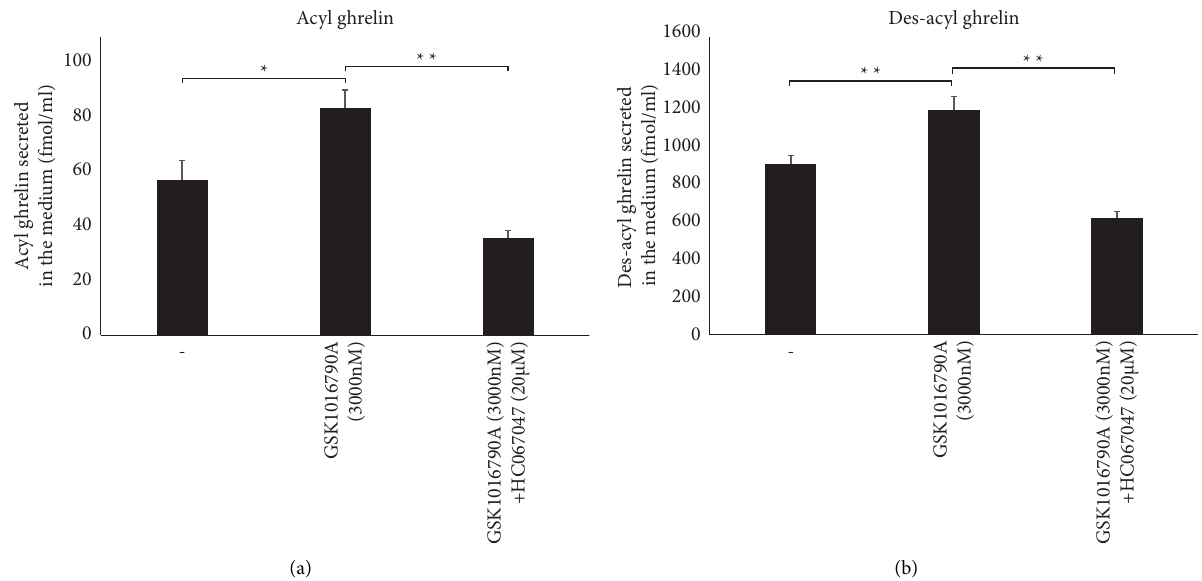
Figure 5: Regulation of ghrelin secretion by the TRPV4 agonist and antagonist in MGN3-1 cells. (a) Te amount of secreted acyl ghrelin after four-hour treatment of MGN3-1 cells with GSK1016790A (3 μ M) or HC067047 (20 μ M) +GSK1016790A (3 μ M). (b) Te amount of secreted des-acyl ghrelin after four-hour treatment of MGN3-1 cells with GSK1016790A (3 μ M) or HC067047 (20 μ M) +GSK1016790A (3 μ M) ( ∗ p < 0 . 05; ∗∗ p < 0 . 01; n � 6; error bars: standard error of the